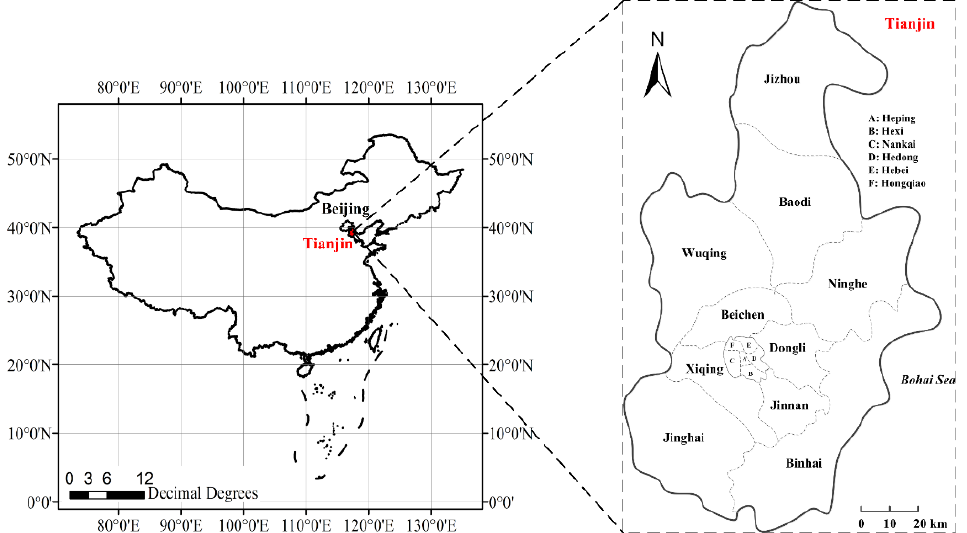
Figure 1. Location of Tianjin on the map of China.